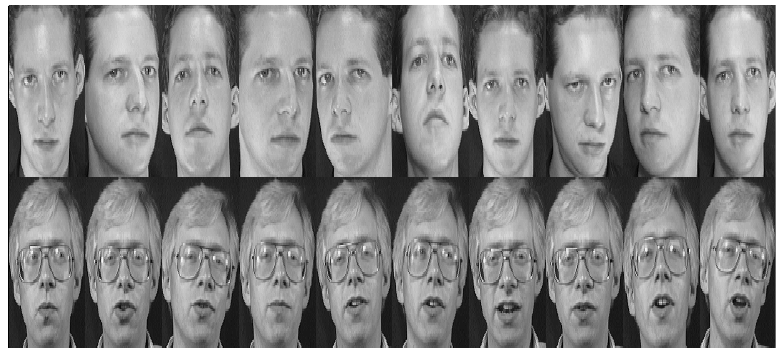
Figure 2. Samples from the ORL face dataset.